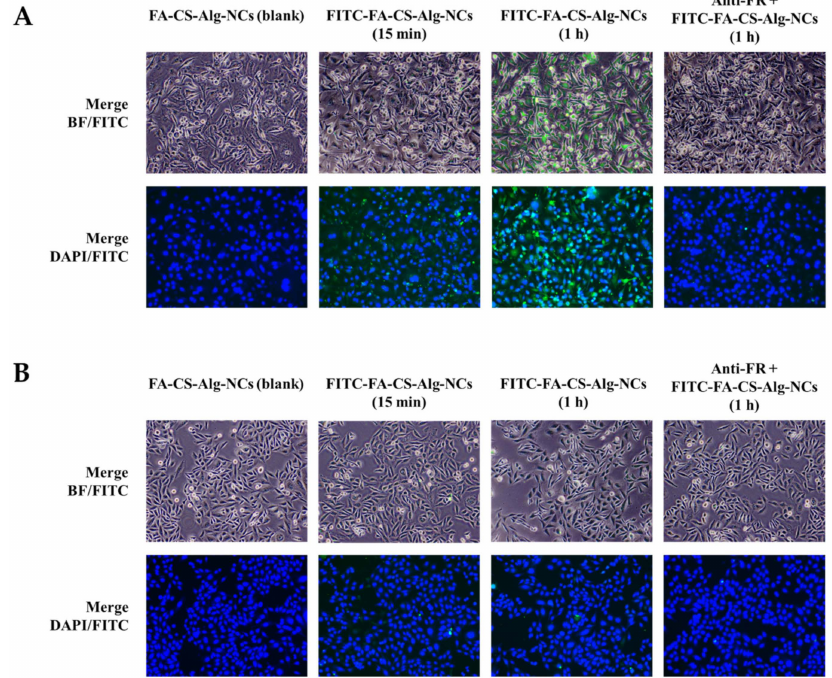
Figure 7. Cellular uptake of FITC-FA-CS-Alg-NCs in ( A ) MDA-MB-231 and ( B ) MCF-10A cells at 15 min and 1 h incubation times. Cells were also pre-treated with anti-human folate receptors αβ antibody (anti-FR) for 30 min prior to FITC-FA-CS-Alg-NCs treatment for 1 h. The green color indicates the uptake of FITC-FA-CS-Alg-NCs, while the blue color indicates the nuclei stained with DAPI. Merged images between brightfield (BF)-FITC and DAPI-FITC show the internalization of FITC-FA-CS-Alg-NCs in the